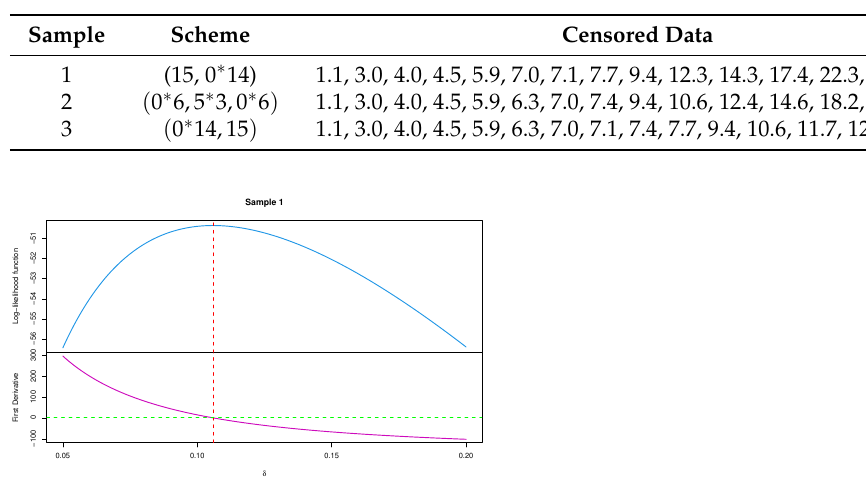
Table 3. Three PT-IIC samples from mechanical equipment data.